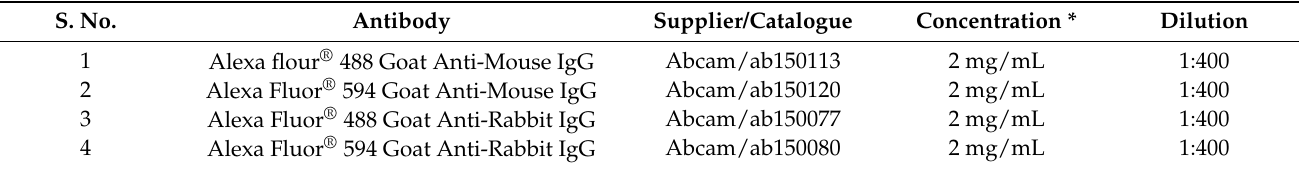
Table 2. List of Secondary Antibodies used in